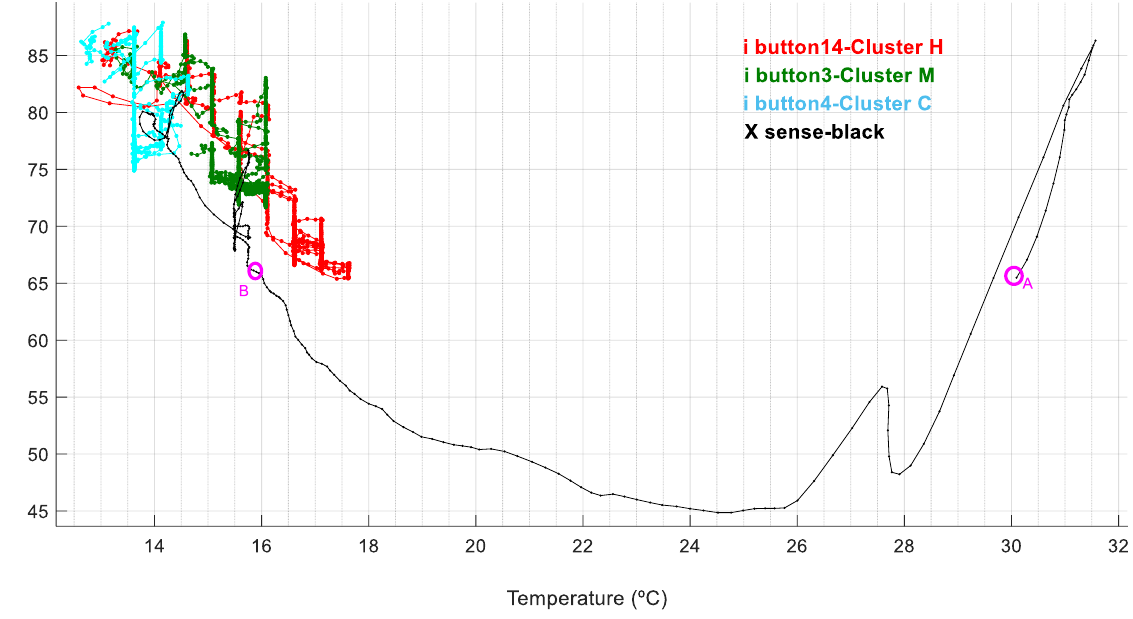
Figure 4. Records of temperature and relative humidity registered throughout the transport itinerary (Jandaíra, Brazil to Castellón, Spain) for a representative sensor of each cluster and for Xsense logger. Data between point A and point B correspond to start-up period.